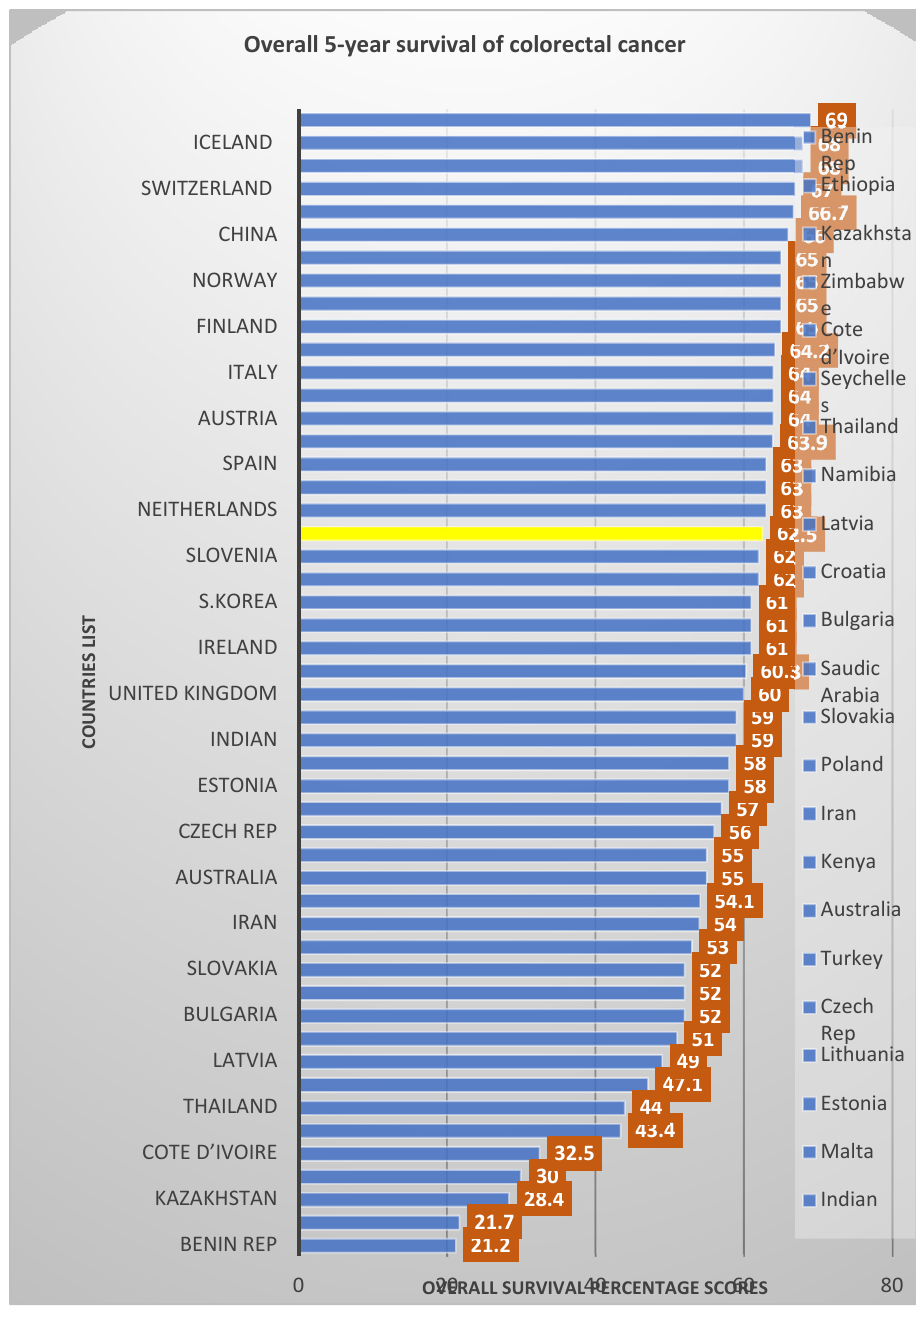
Figure 2. Overall survival percentage score as reported for the different countries in comparison with the present study’s percentage score.